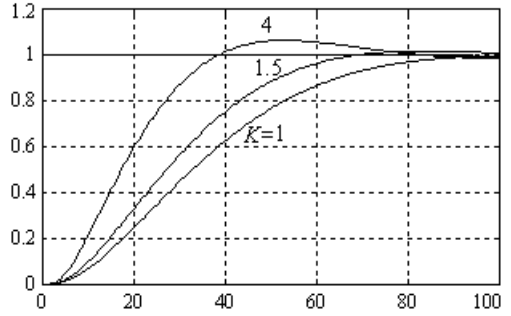
Figure 33. Responses y ( t ) to a unit step setpoint for K = 1; 1.5; 4.